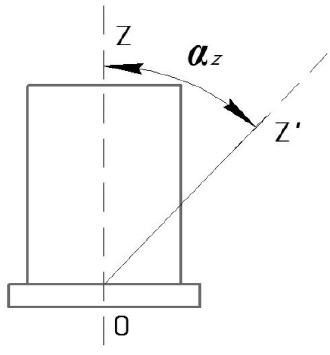
Figure 10. Tilt angle of the SE WSS.